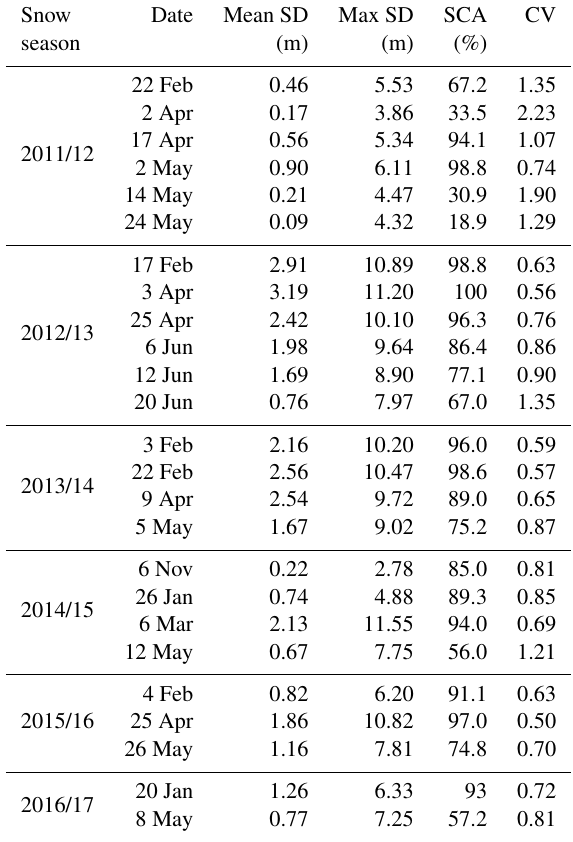
Table 8. Observed mean and maximum snow depth values, snow- covered area (SCA, % of the total area covered by the TLS), and coefficient of variation for the observed snow distribution on the TLS survey